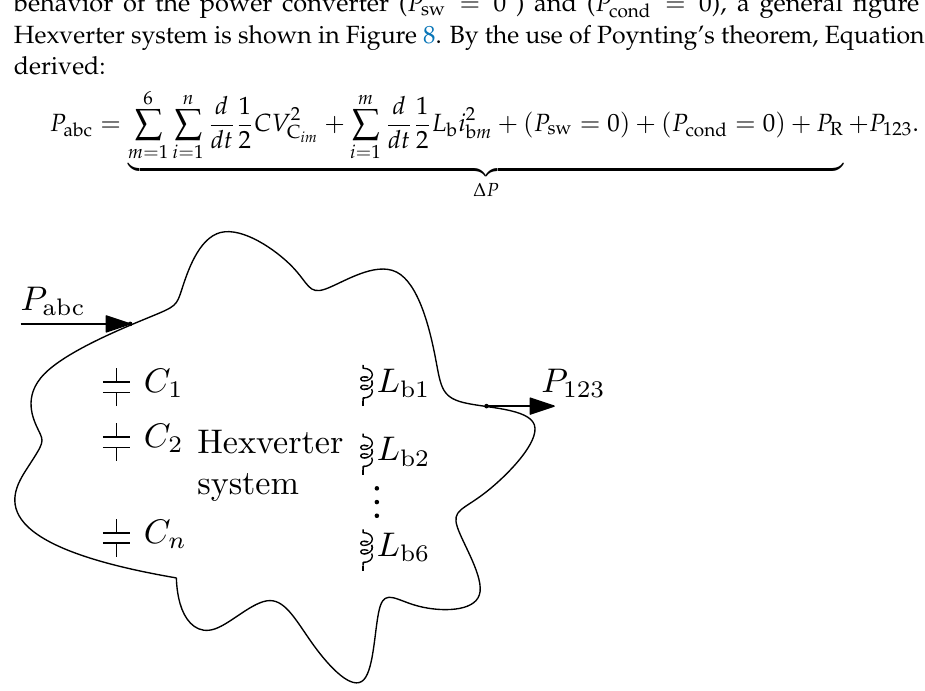
Figure 8. Elements storing energy in the Hexverter